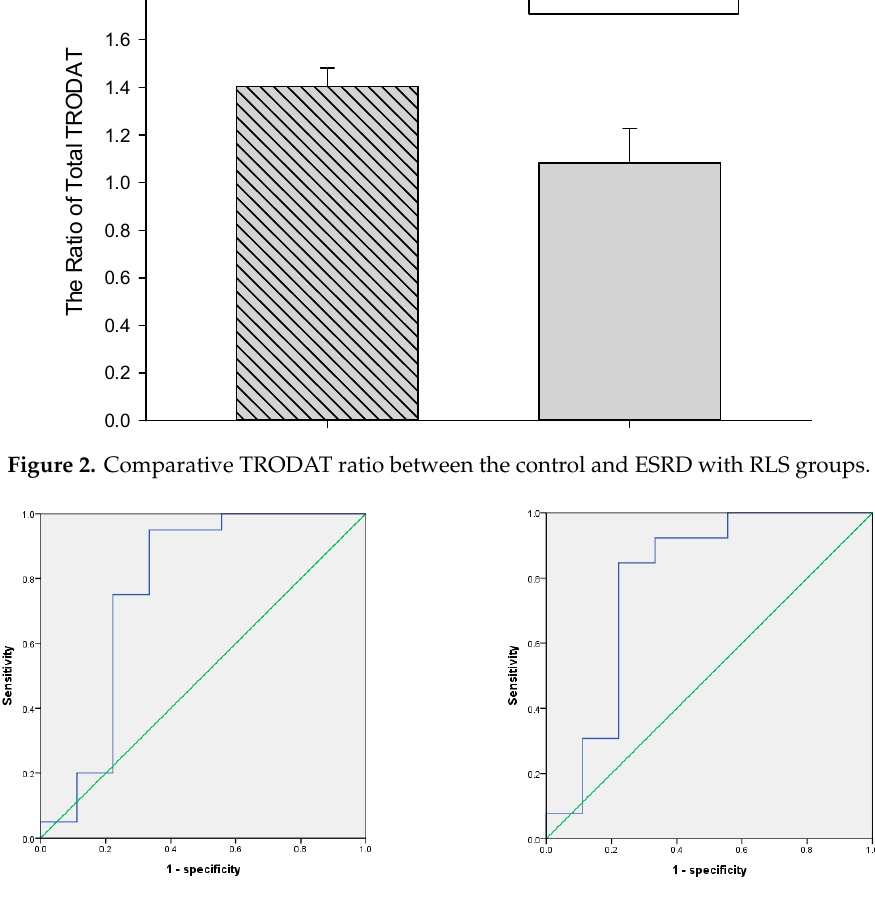
Figure 3. Receiver operating characteristic (ROC) curve for total TRODAT ratio as a predictor of RLS